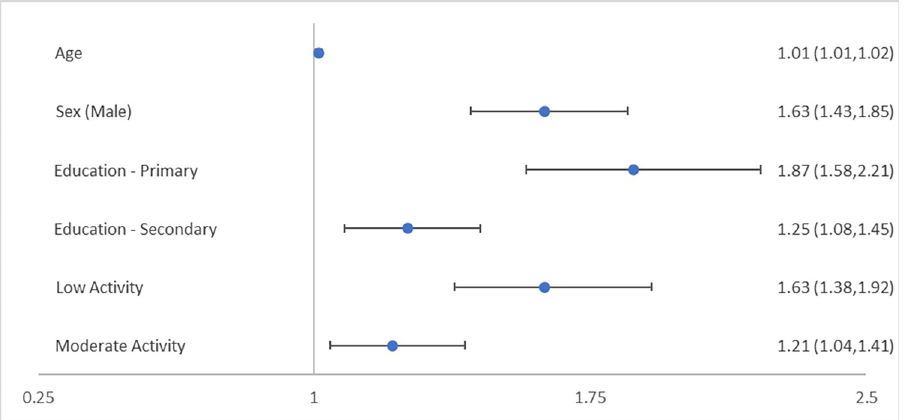
Fig 3. Categorisation of wave 1 TILDA participants by IDF metabolic syndrome (MetS) criteria to estimate odds ratio (95% confidence intervals) for likelihood of MetS. Third level and higher the base reference for education and high levels of physical activity the base reference for physical